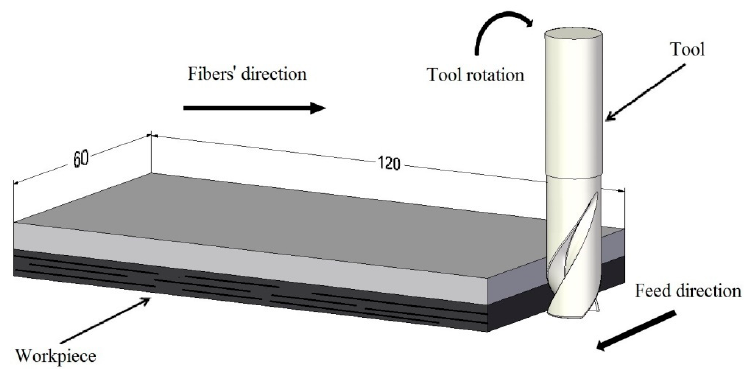
Figure 1. Experimental setup.